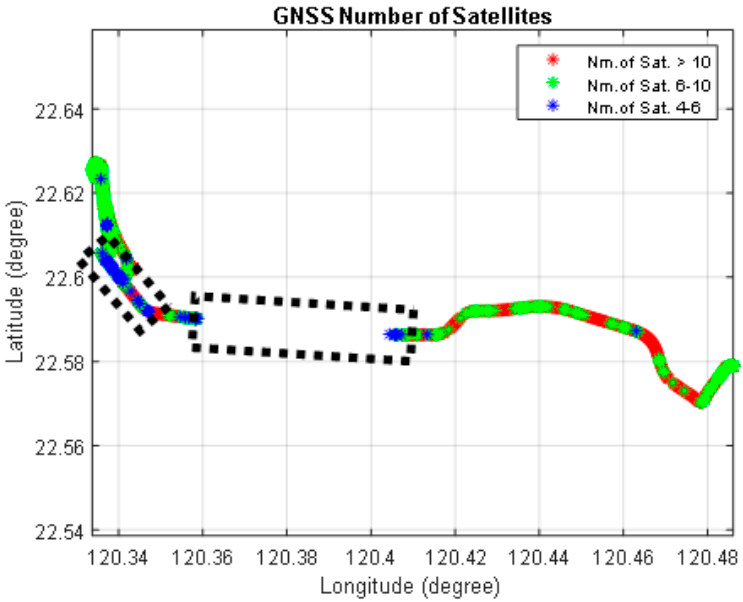
Figure 9. Di ff erential GNSS solution encoded by the number of satellites in a highway